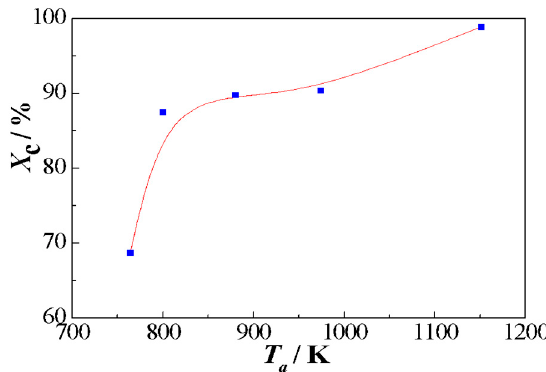
Figure 4. Variation of crystallinity as a function of annealing temperature for the (Fe 0.4 Co 0.6 ) 79 Nb 3 B 18